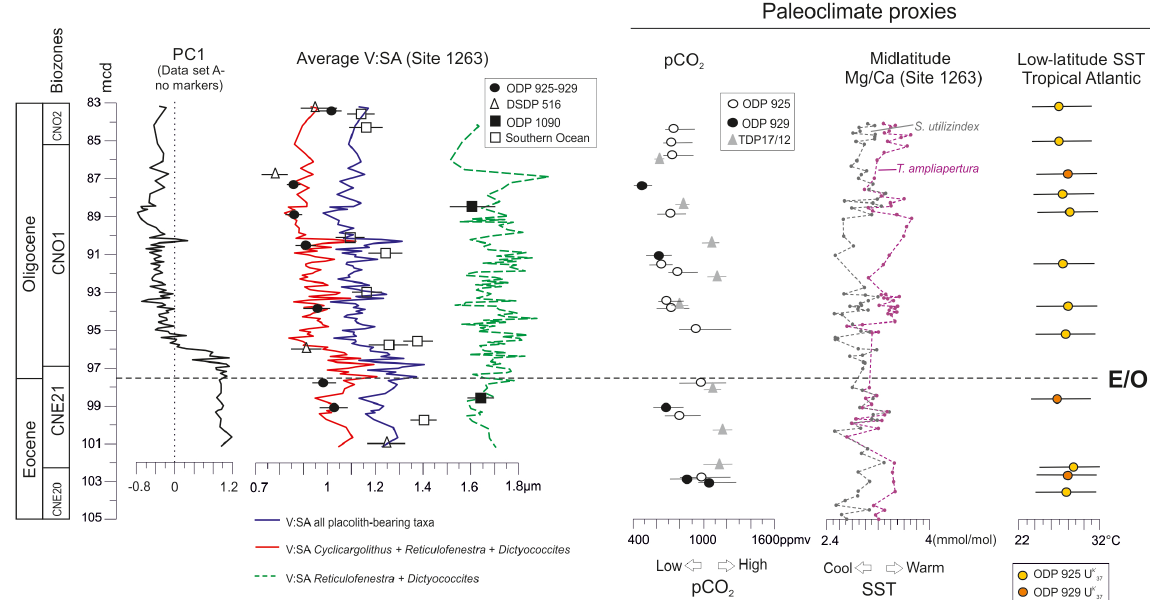
Figure 5. PC1 and cell size trends during the Eocene to Oligocene at Site 1263. The average cell V :SA (µm) of all placolith-bearing species (green area), Reticulofenestra , Dictyococcites and Cyclicargolithus (red solid line) and Reticulofenestra and Dictyococcites (green dotted line) are reported. The average cell V :SA of ODP 925 (black circles; Pagani et al., 2011), DSDP 516 (white triangles; Henderiks and Pagani, 2008), DSDP 511–277 (white squares) and ODP 1090 (black squares) from the Southern Ocean (Pagani et al., 2011), and alkenone-based p CO 2 (ppmv) from ODP 925 (white circles; Pagani et al., 2011; Zhang et al., 2013), ODP 929 (black circles; Pagani et al., 2011), and boron-isotope-based p CO 2 from TDP17/12 (grey triangles; Pearson et al., 2009) are also shown. For comparison with sea surface temperature (SST) proxies, the Mg/Ca (mmolmol − 1 ; Peck et al., 2010) at Site 1263 and the SST from U k ’ at a low latitude in the Atlantic 37 Ocean (Liu et al., 2009) are also displayed. The positions of EOB and Step 2 at Site 1263 are